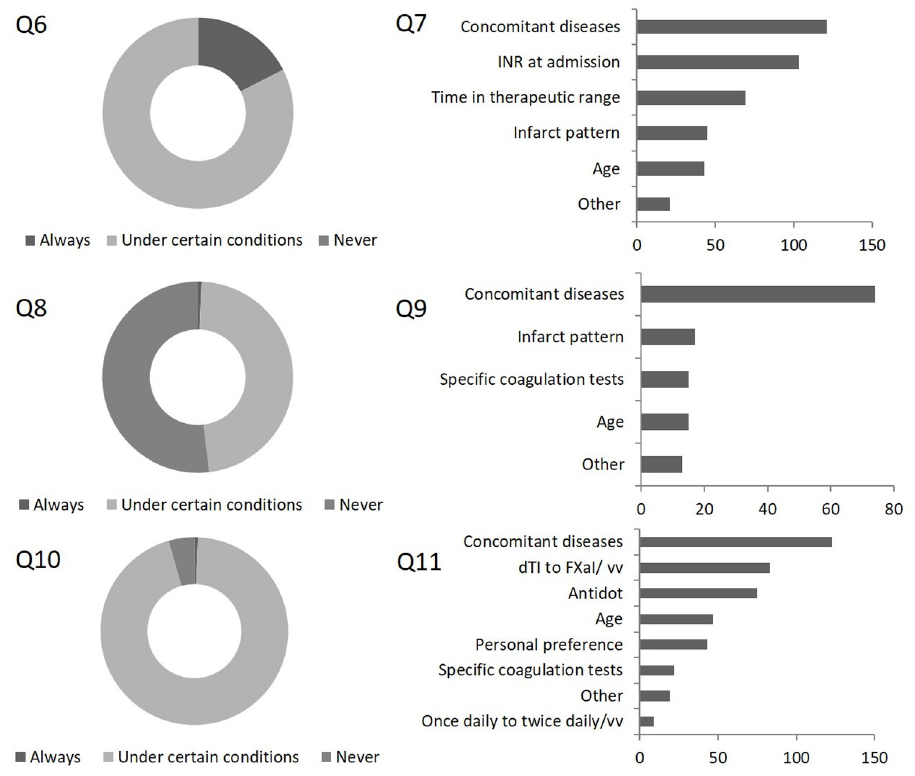
Fig 2. Question (Q) 6 : Do you switch anticoagulation from vitamin K antagonists (VKAs) to direct oral anticoagulants (DOACs) in patients who suffer an acute ischemic stroke (AIS) under VKA treatment?